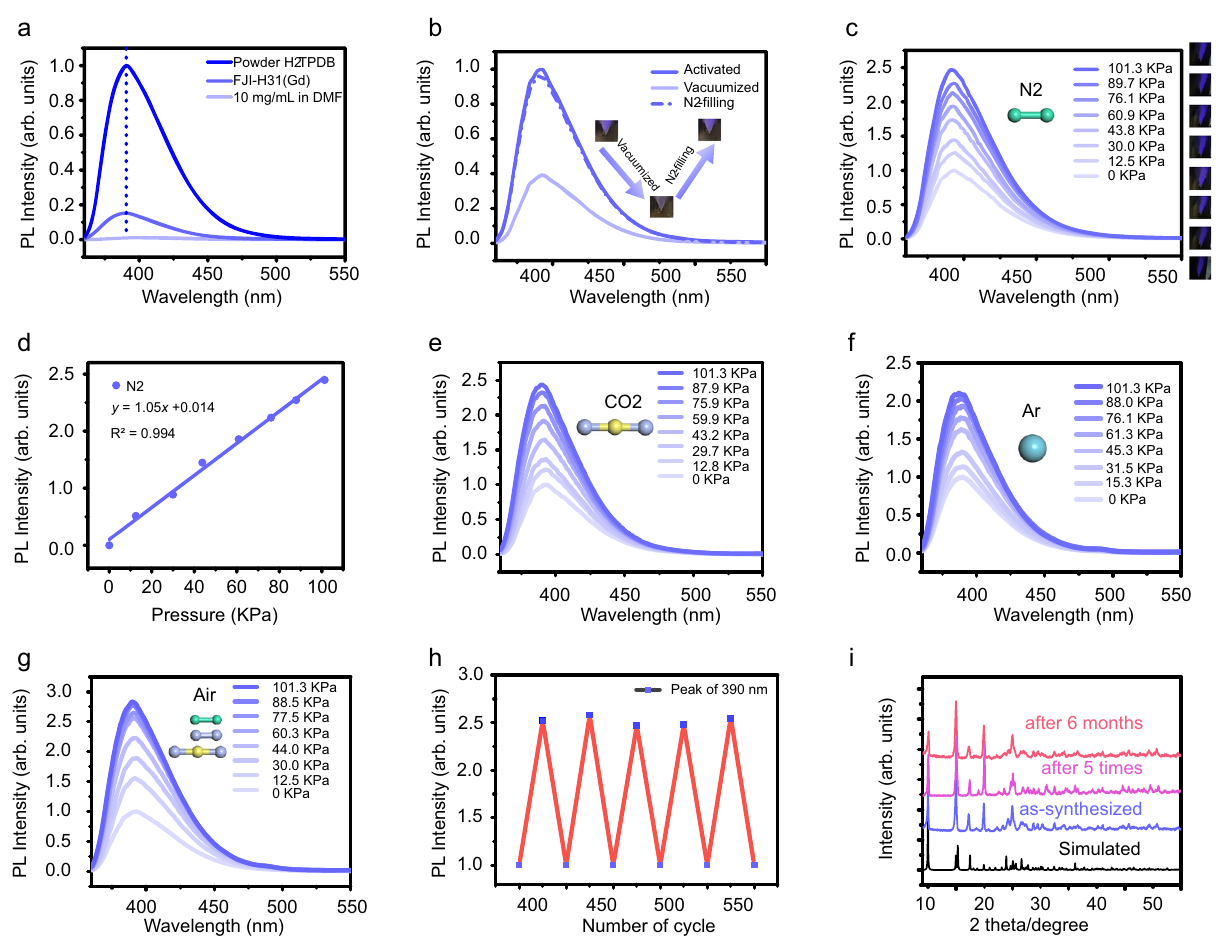
Fig. 2 Gas-pressure-dependent luminescence properties of FJI-H31 and structural stability of FJI-H31. a Emission spectra of powder H 2 TPDB, FJI-H31 and the dilute solution of H 2 TPDB (10 mg/mL in DMF), excited at 338 nm. b Emission spectra of activated, vacuumized and N 2 - fi lling FJI-H31(Gd); inset: photographs of activated, vacuumized and N 2 - fi lling FJI-H31(Gd). c Emission spectra of FJI-H31(Gd) at different nitrogen (N 2 ) pressures, left: the different emission color of FJI-H31(Gd) under different pressures. d The fi tted curves for pressure-dependent intensity of FJI-H31(Gd) at 390 nm, N 2 . e Emission spectra of FJI-H31(Gd) at different carbon dioxide (CO 2 ) pressures. f Emission spectra of FJI-H31(Gd) at different argon (Ar) pressures. g Emission spectra of FJI-H31(Gd) at different Air pressures. All spectra and photographs are excited at 338 nm, RT. h Reusability luminescence of FJI-H31(Gd) response to air pressure of fi ve consecutive cycles; monitored at 390 nm. i Powder XRD patterns of FJI-H31: simulated, as-synthesized, after 5 times cycles and after 6